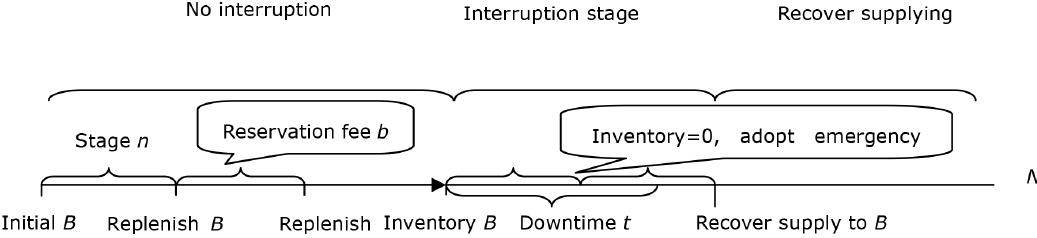
Figure 1. Operation course based on BI insurance and emergency supply